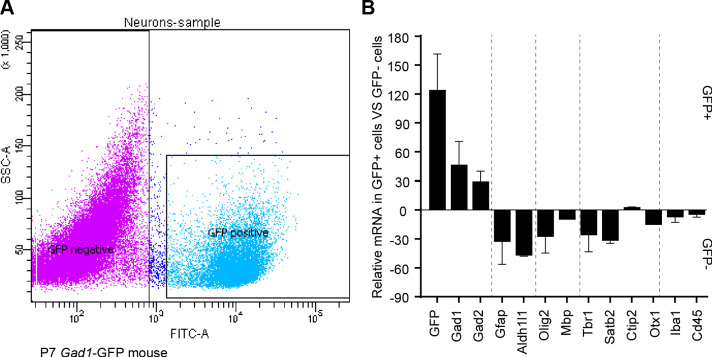
GABAergic markers are enriched in GFP positive FACS-sorted cells from Gad1-GFP mice.(A) Representative flow cytometry plot, sorting GFP+ cIN from Gad1-GFP mice. (B) Real-time RT-PCR analysis of GABAergic and non- GABAergic markers in positive and negative FACS-sorted GFP cells from P7 Gad1-GFP mice.